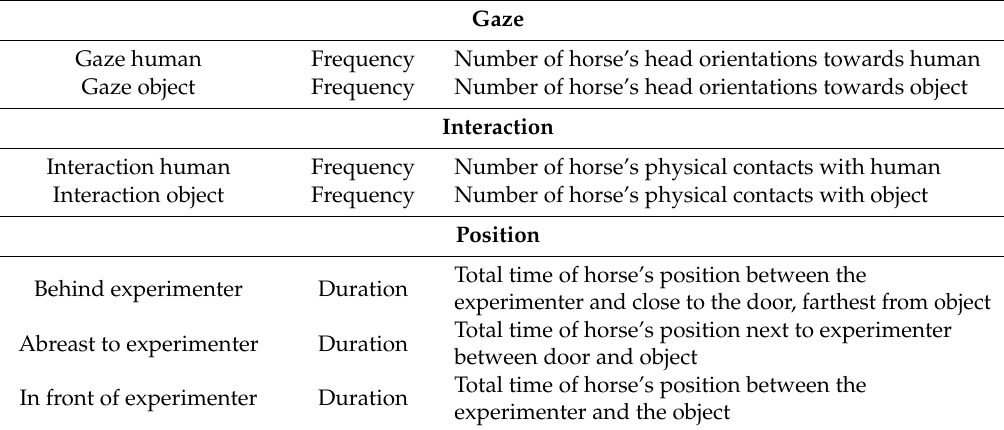
Table 2. Ethogram of all behaviors